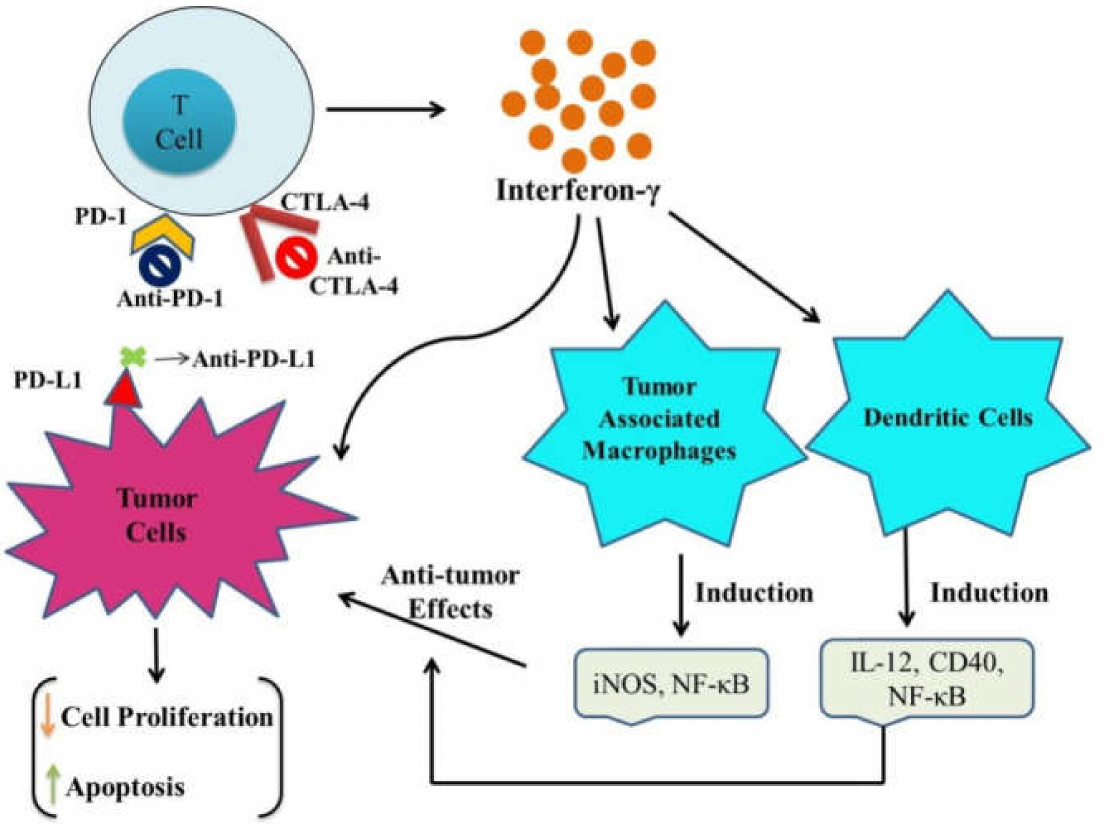
Figure 2. Possible molecular mechanism associated with main immune checkpoints (CTLA-4, PD-1, and PD-L1) blockage therapy in malignant cells. Immune checkpoint blockade activates the function of T cells that secrete IFN- γ which consecutively restores the antitumor potential of tumor-associated macrophages, and dendritic cells (Arrows indicates: ↑ Decreaseed and ↓